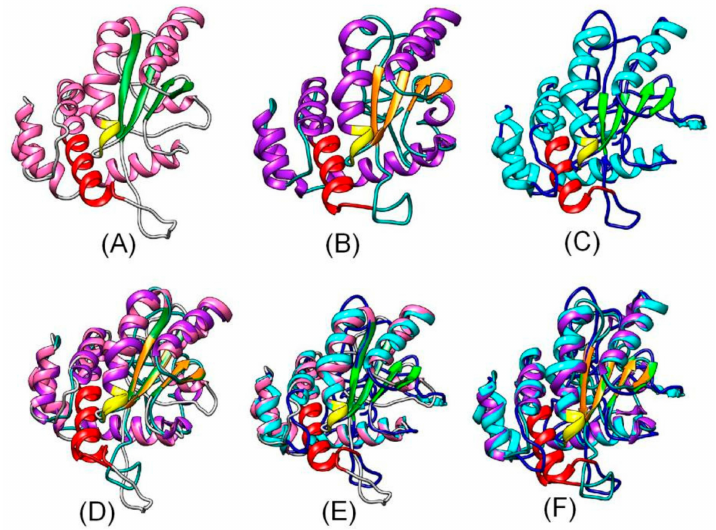
Figure 2. Homology of the predicted tertiary structures of HoNP_006323 ( A ) H. sapiens (NP_006323.2), and homology of the predicted tertiary structures of AT1G07080 ( B ), POPTR_0016s12980 ( C ), HoNP_006323.2 and AT1G07080 ( D ), HoNP_006323 and POPTR_0016s12980 ( E ), and POPTR_0016s12980 and AT1G07080 ( F ).Red, CXXCmotif; yellow, CQHGX 2 ECX 2 NX 4 Cmotif. Pt, P . trichocarpa ; At, A . thaliana ; Ho, Homosapiens